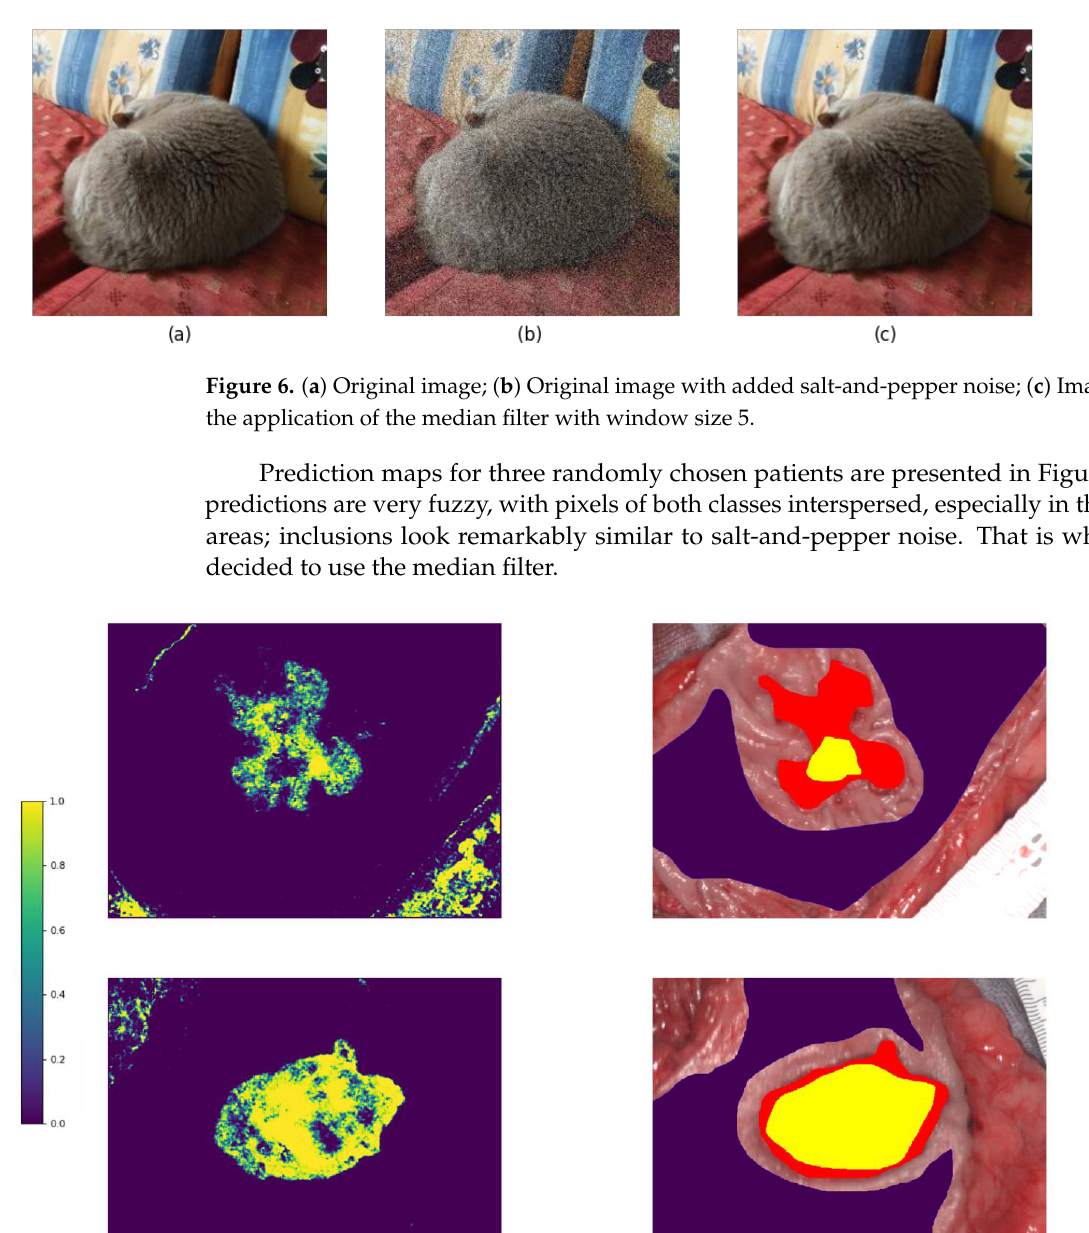
Figure 5. Example of how the median filter works.